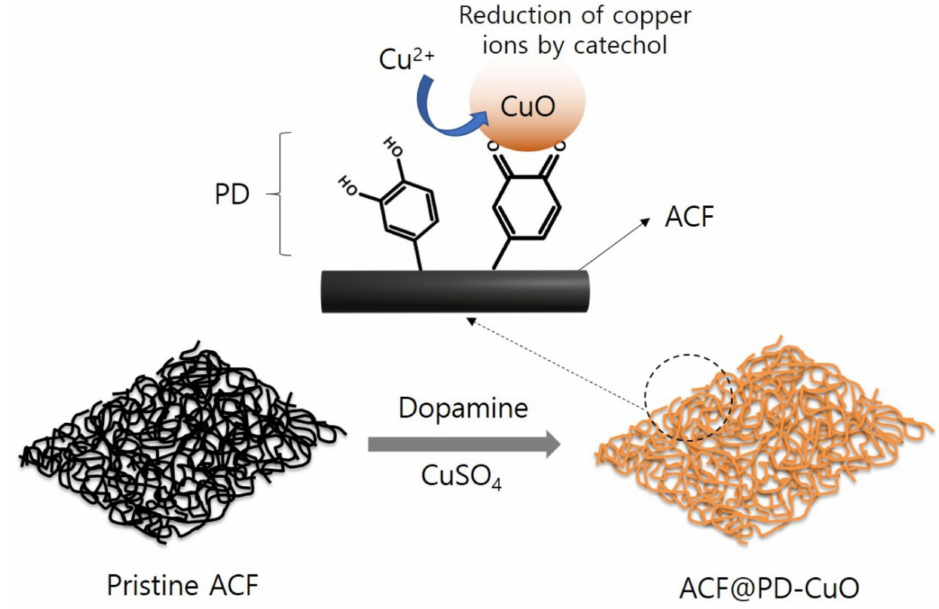
Figure 1. Schematic illustration of the mechanism of simultaneous deposition of polydopamine (PD) and CuO on the activated carbon fiber (ACF)